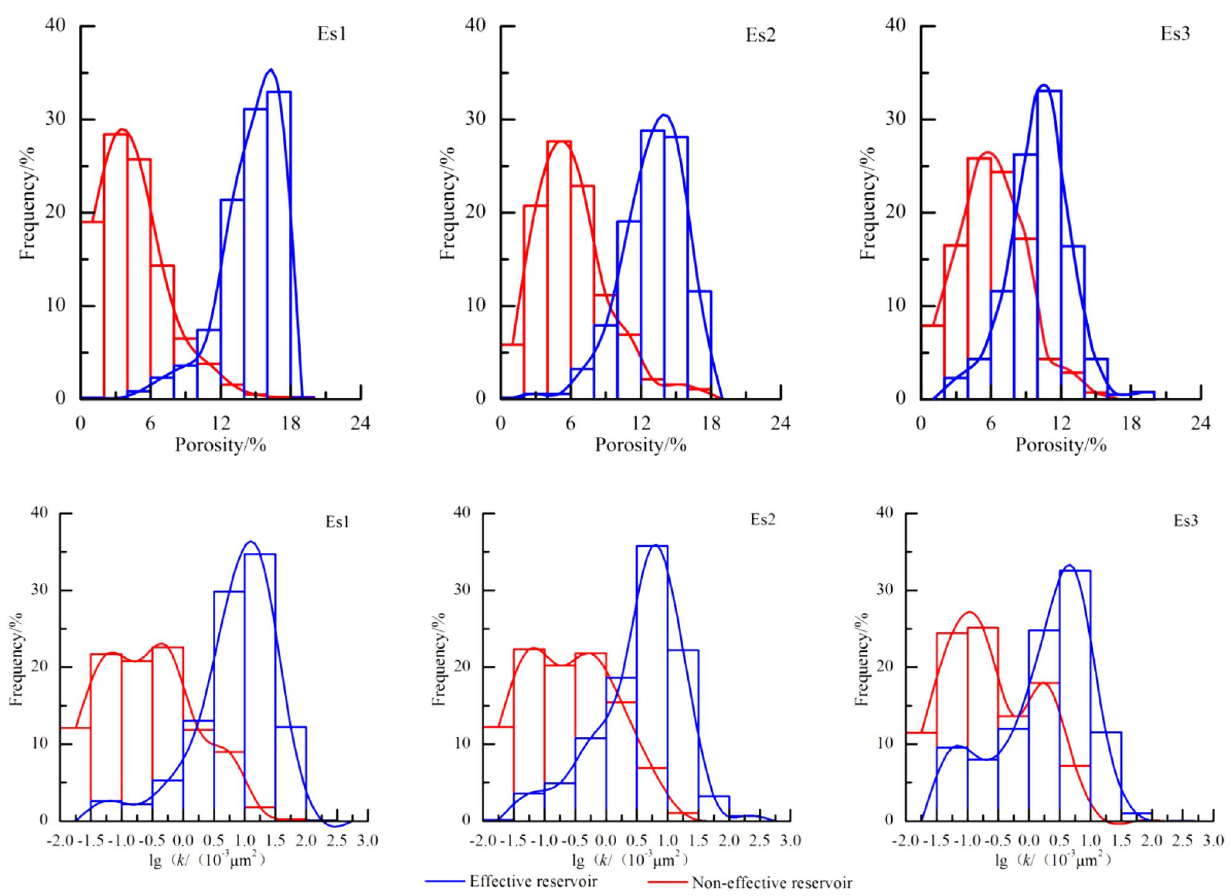
Fig. 4 Lower limit of the physical properties determined by the frequency curve intersection method Table 3 Comparison matrix of three methods to determine the lower limit of